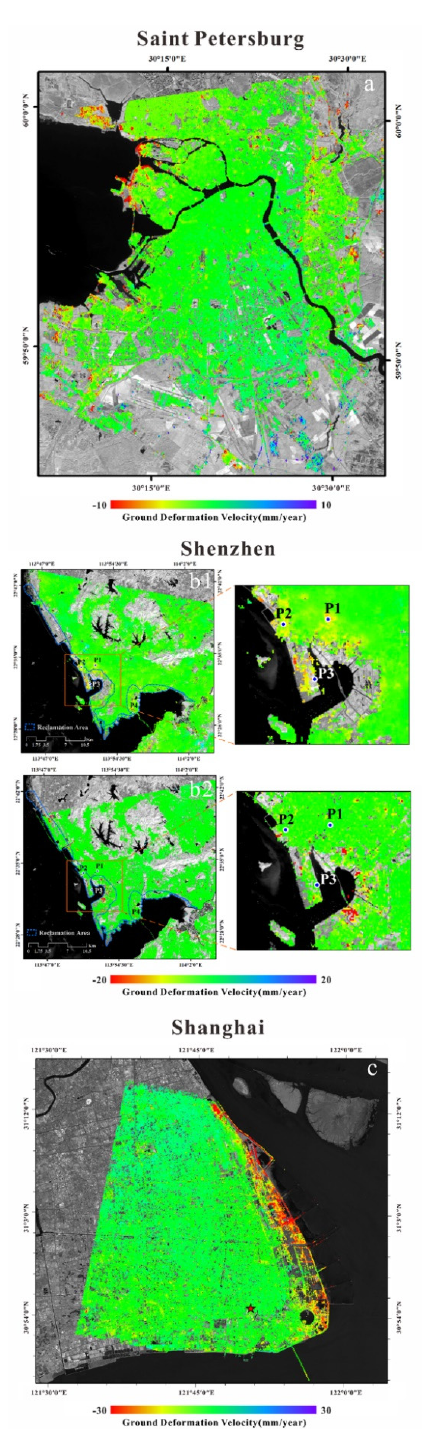
Figure 2. The geocoded mean ground displacement velocity maps of the coastal regions of Saint Petersburg ( a ), Shenzhen ( b1 , b2 ), and Shanghai ( c ). ( a ) The geocoded mean line-of-sight deformation velocity map of Saint Petersburg retrieved using Sentinel-1A/B descending track images acquired from 2016 to 2018 (refer to [261]); ( b1 ) The map of 2007–2010 vertical (subsidence/uplift) deforma- tion velocity derived from ENVISAT ASAR images (refer to [240]); ( b2 ) The map of vertical mean deformation velocity derived from Sentinel-1A data acquired from June 2019 to June 2020; ( c ) The LOS mean displacement velocity map retrieved by the COSMO-SkyMed dataset acquired from 2013 to 2016 (refer to